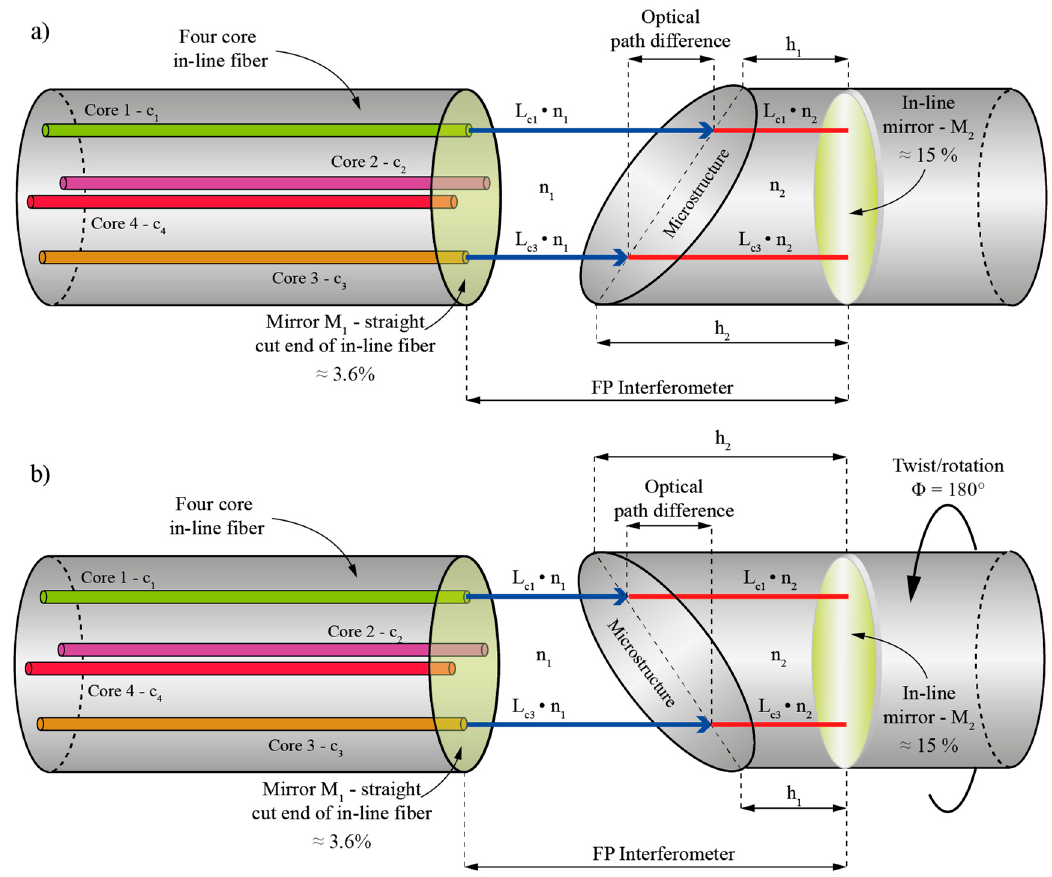
Figure 3. ( a ) Relaxed sensor and ( b ) 180-degree twist/rotation applied to the sensor.